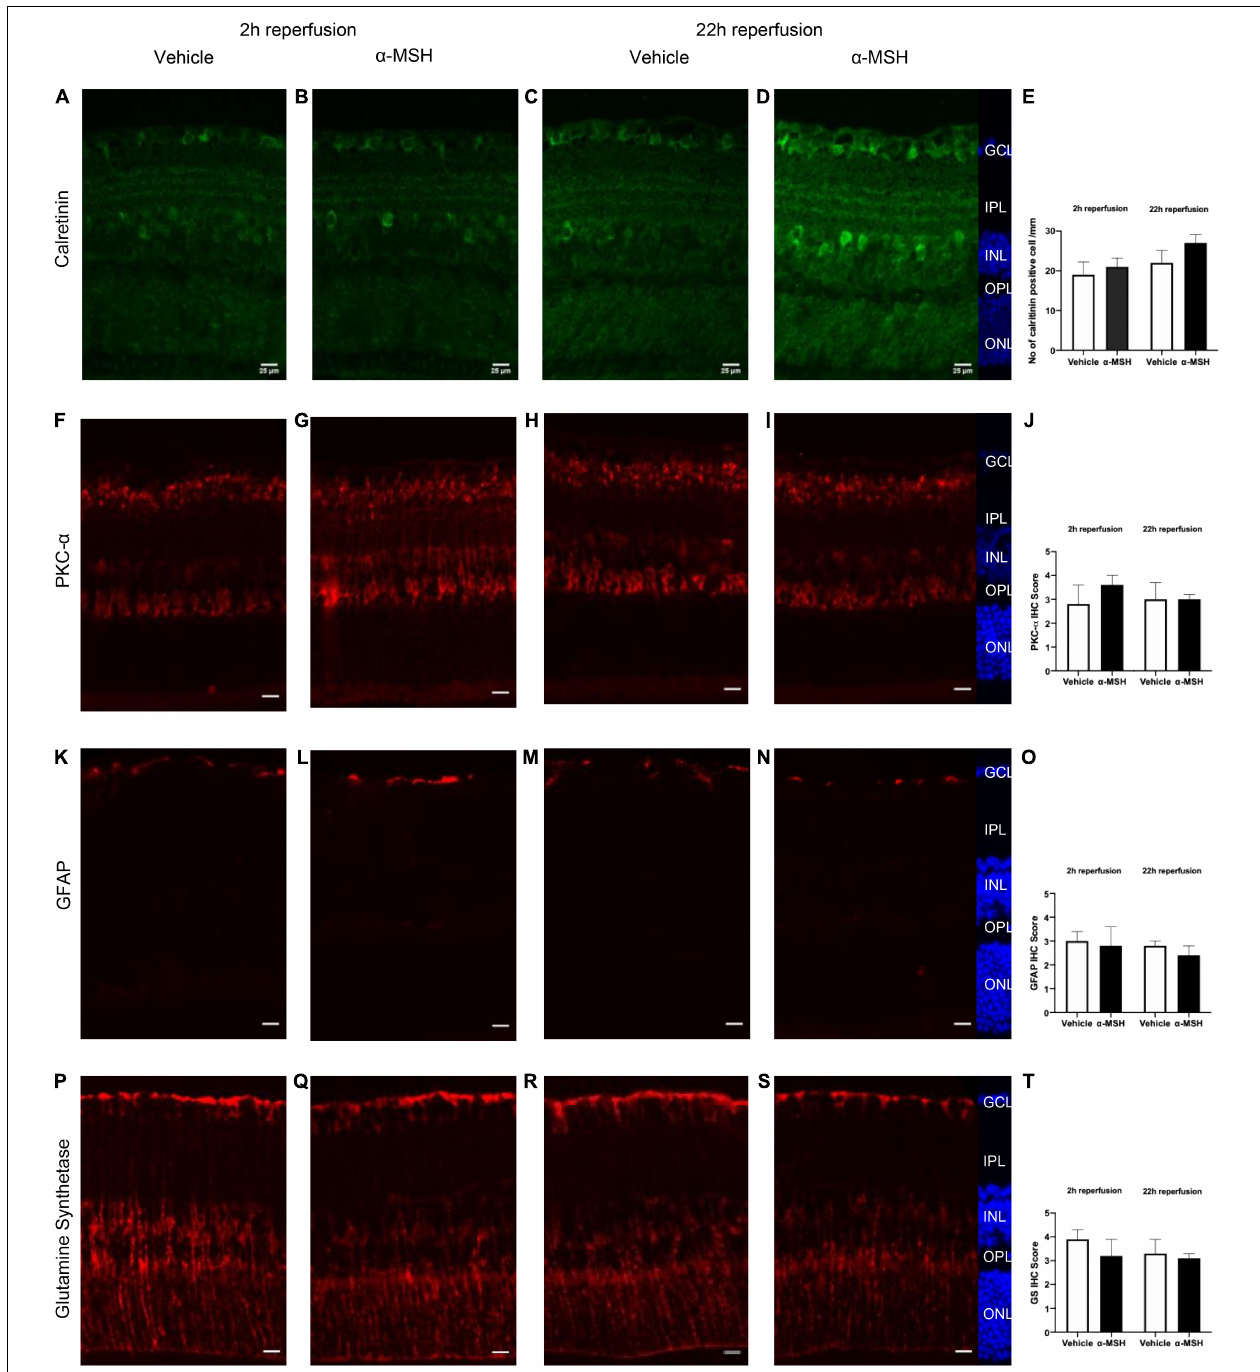
FIGURE 4 | Immunoreactivities of retinal neuronal and glial cells after I/R injury. (A–D) Calretinin expression was higher in α -MSH-treated animals at 22 h of reperfusion. (E) Number of calretinin positive cell/mm. (F–I) PKC- α expression was higher in α -MSH-treated animals at 2 h of reperfusion. (J) IHC scores for PKC- α . (K–N) GFAP expression was similar between the groups in both experimental conditions. (O) IHC scores for GFAP. (P–S) α -MSH reduced the GS expression at 2 h of reperfusion. (T) IHC scores for GS. Mann-Whitney U -Test, n = 6 for each group. Scale bar = 25 µ m.